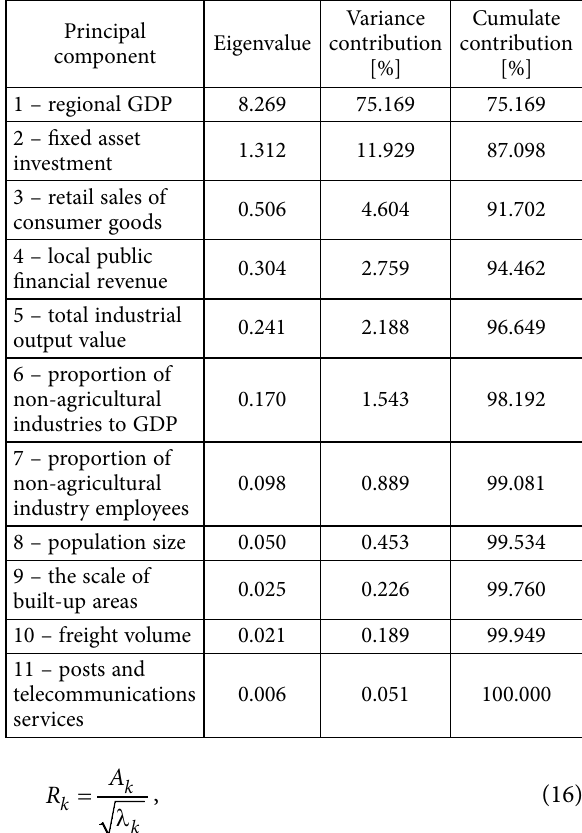
Table 1. Eigenvalue and principal component contribution rate